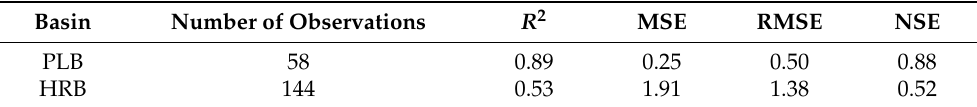
Table 2. Results of SPARROW Table 1. Results of SPARROW models.